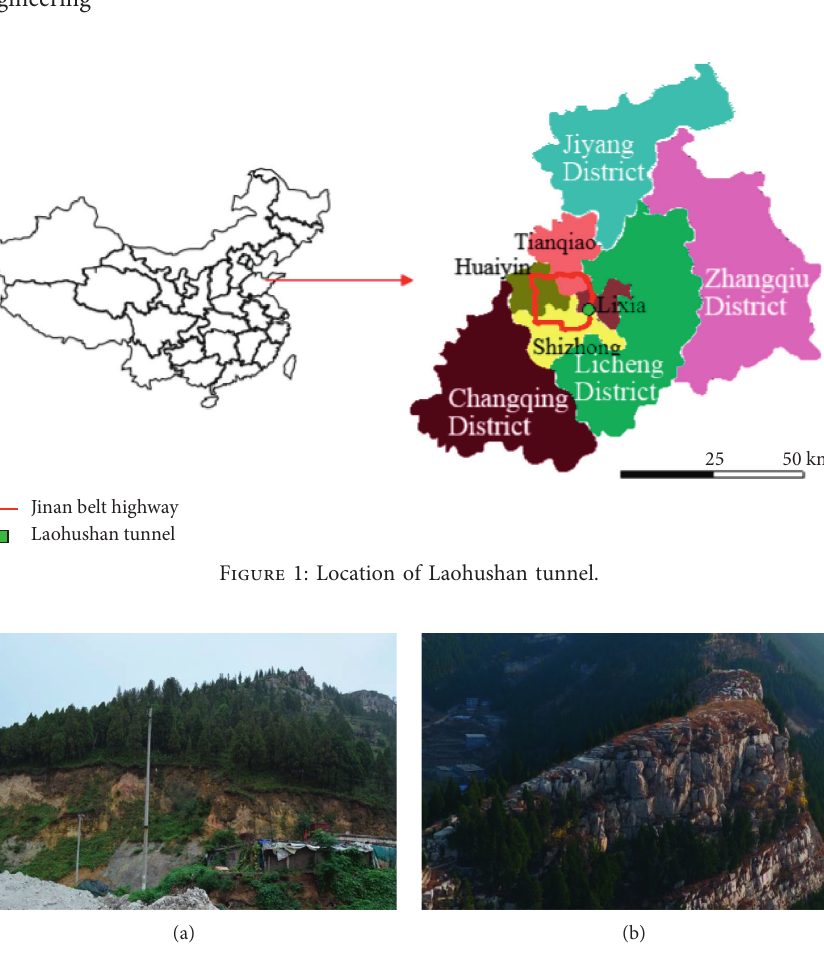
Figure 2: The landform of tunnel